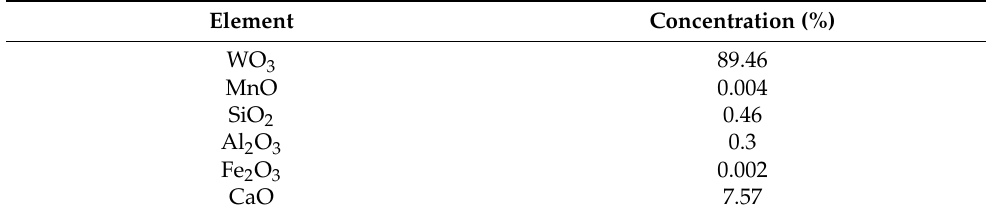
Table 6. Chemical compositions of wolframite leachate.